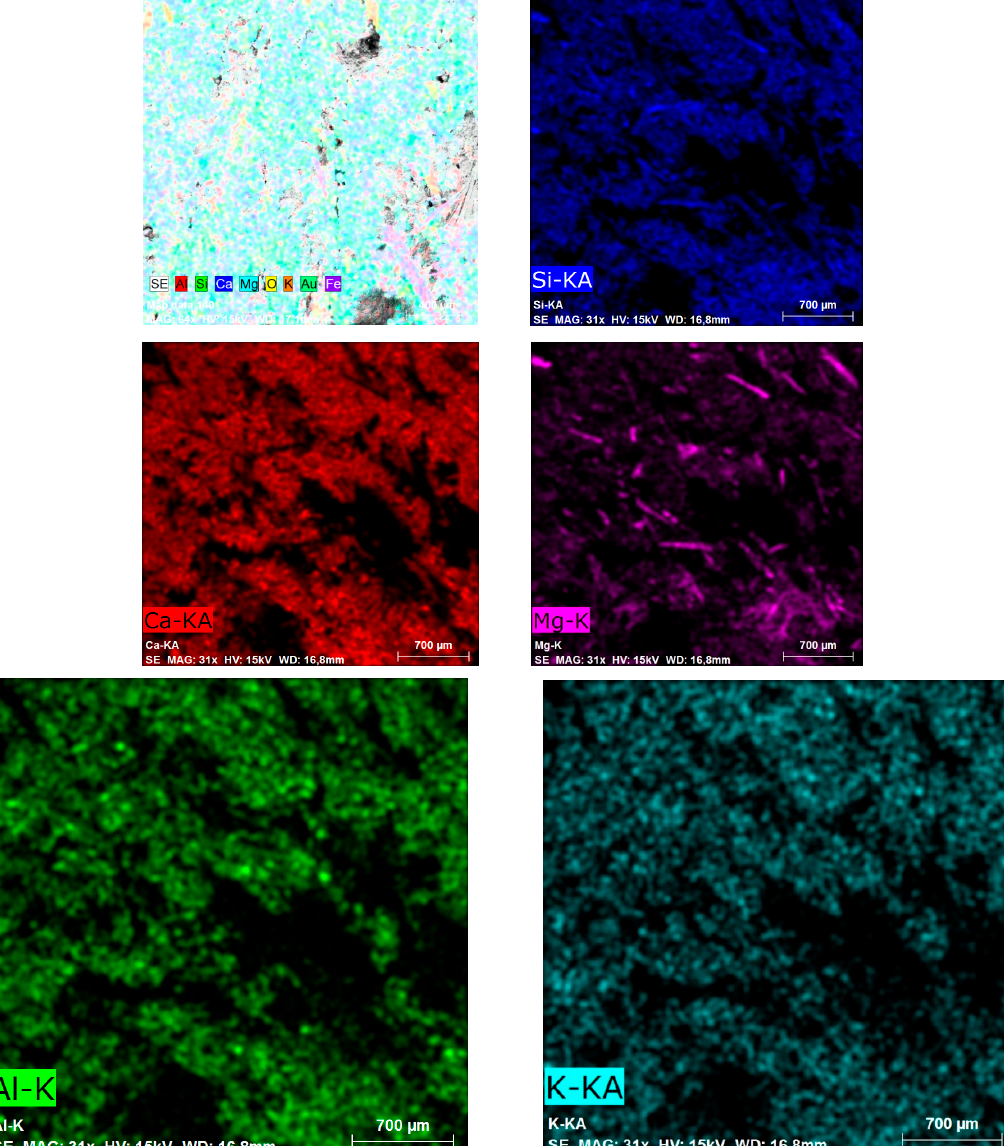
Figure 4. SEM micrographs of surface morphology of the asbestos–cement sample and map of the areal distribution and relative proportion (intensity) of all and the selected elements (Si, Ca, Mg, Al, K) over the scanned area (magnification 31 times).